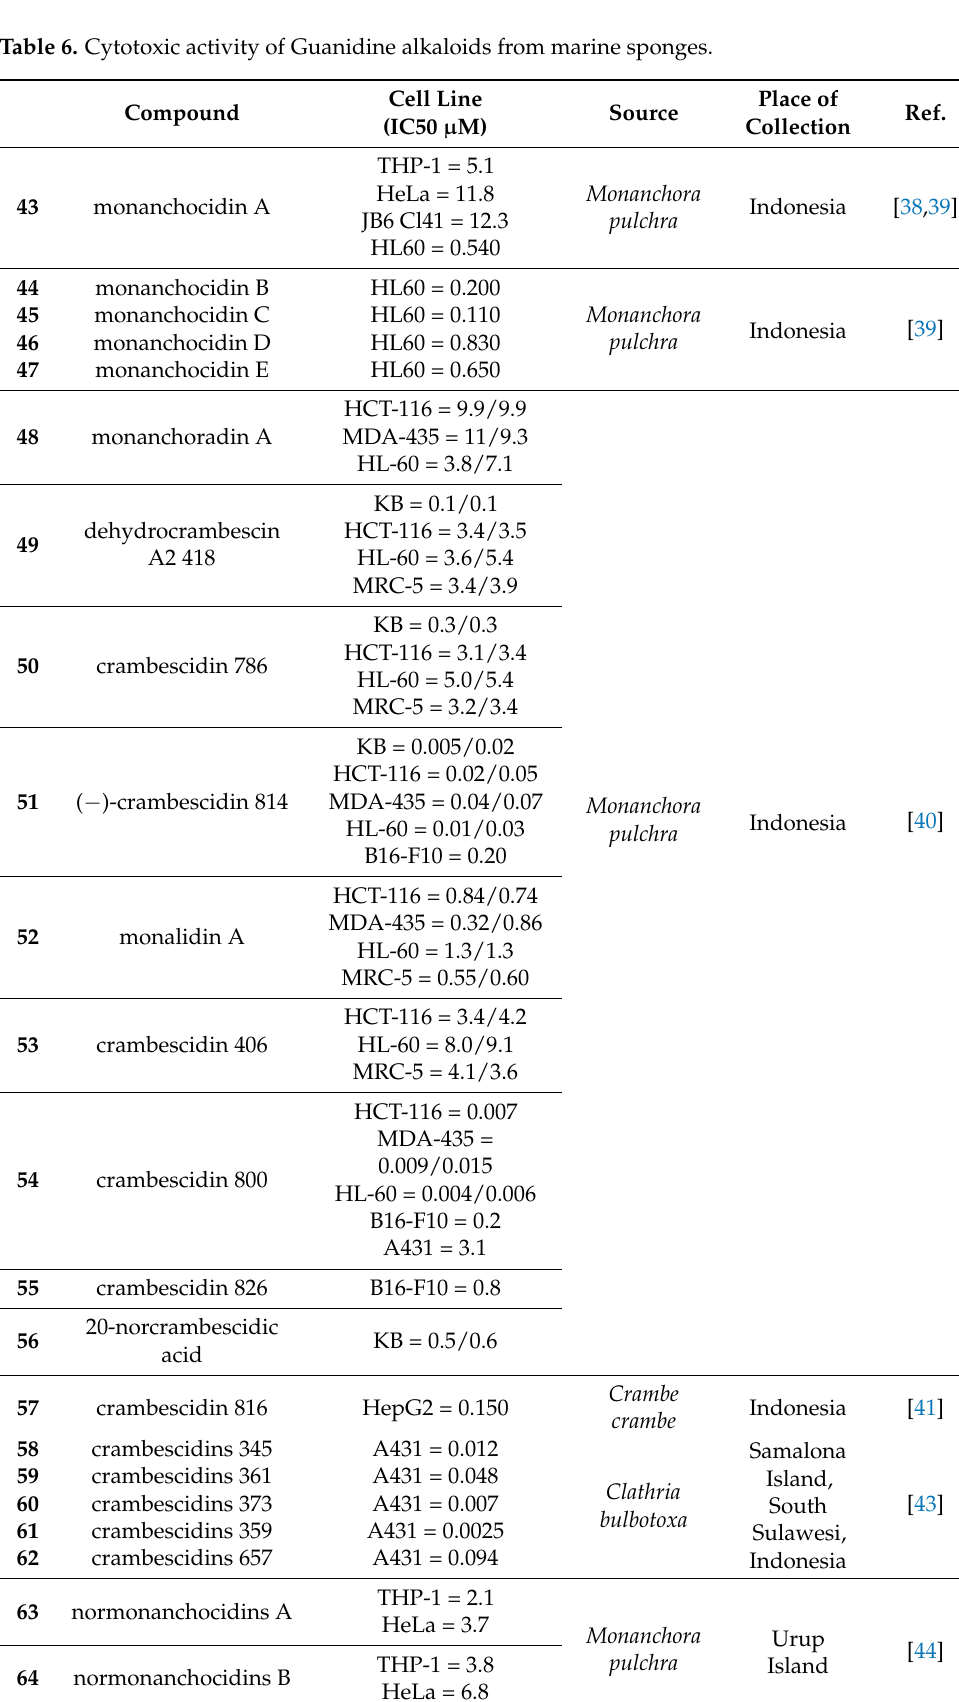
Table 6. Cytotoxic activity of Guanidine alkaloids from marine